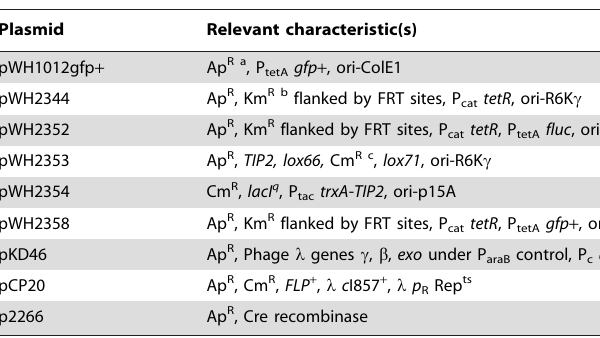
Table 2. Plasmids used in this study.